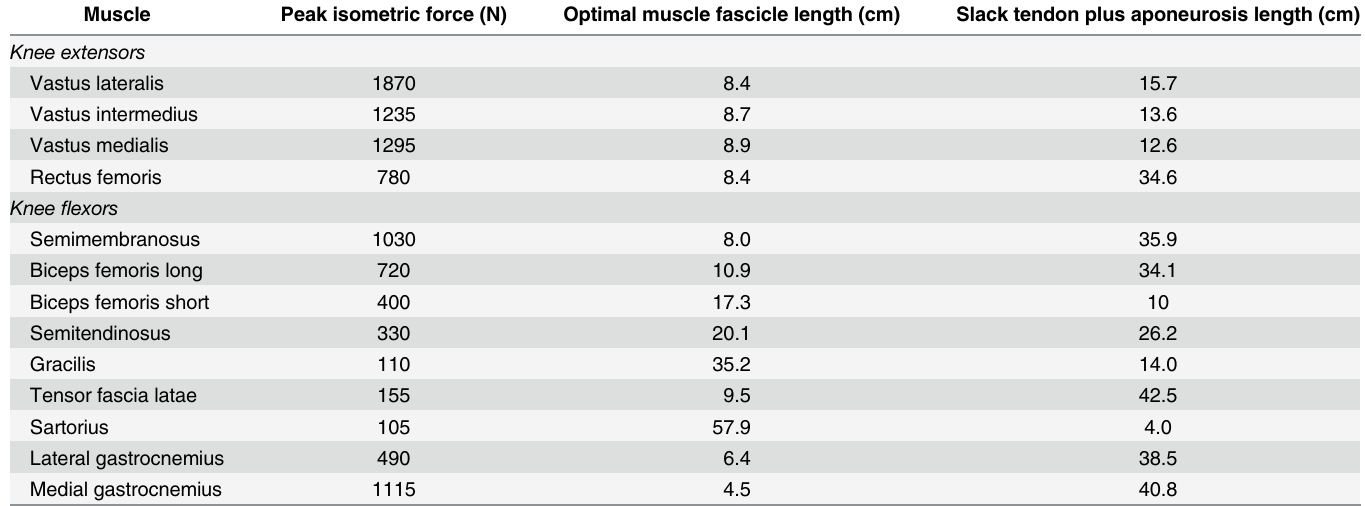
Table 1. Modeled muscles and corresponding morphometric parameters. Parameters are identical to those defined in Delp [30]. Fiber type composition of all modeled muscles was set to 50% slow and 50% fast-twitch fibers. Muscle Peak isometric force